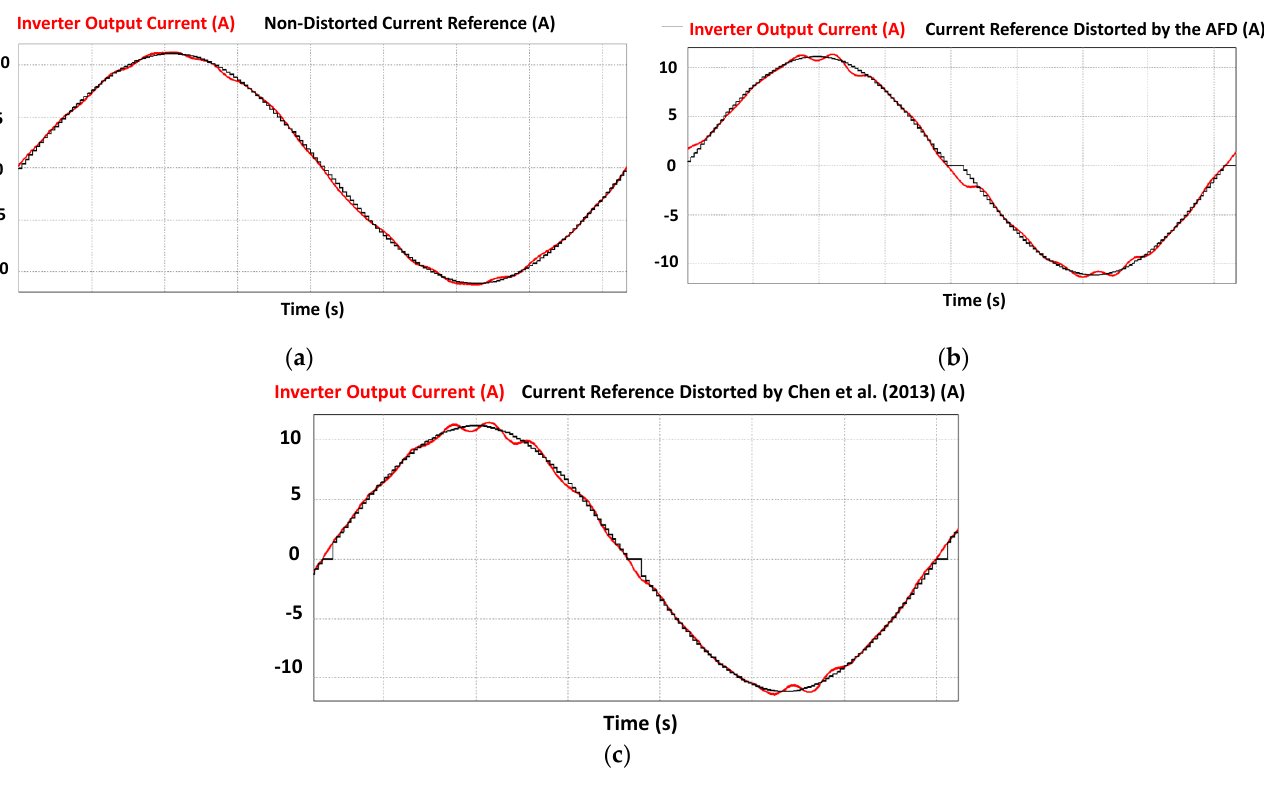
Figure 15. Inverter output current and the current reference for: ( a ) a non-active AIP implemented condition; ( b ) a Classic AFD implemented condition; ( c ) an AFD proposed in Chen et al. (2013) [24] implemented condition.